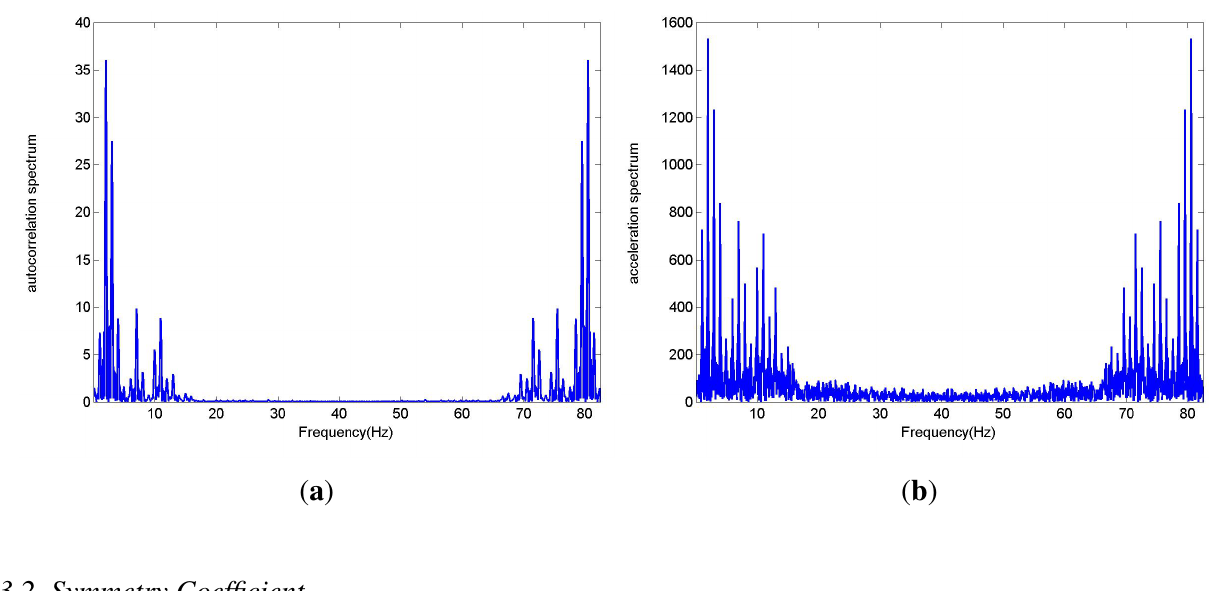
Figure 3. Acceleration spectrum: ( a ) FFT of autocorrelation; ( b ) FFT of acceleration.